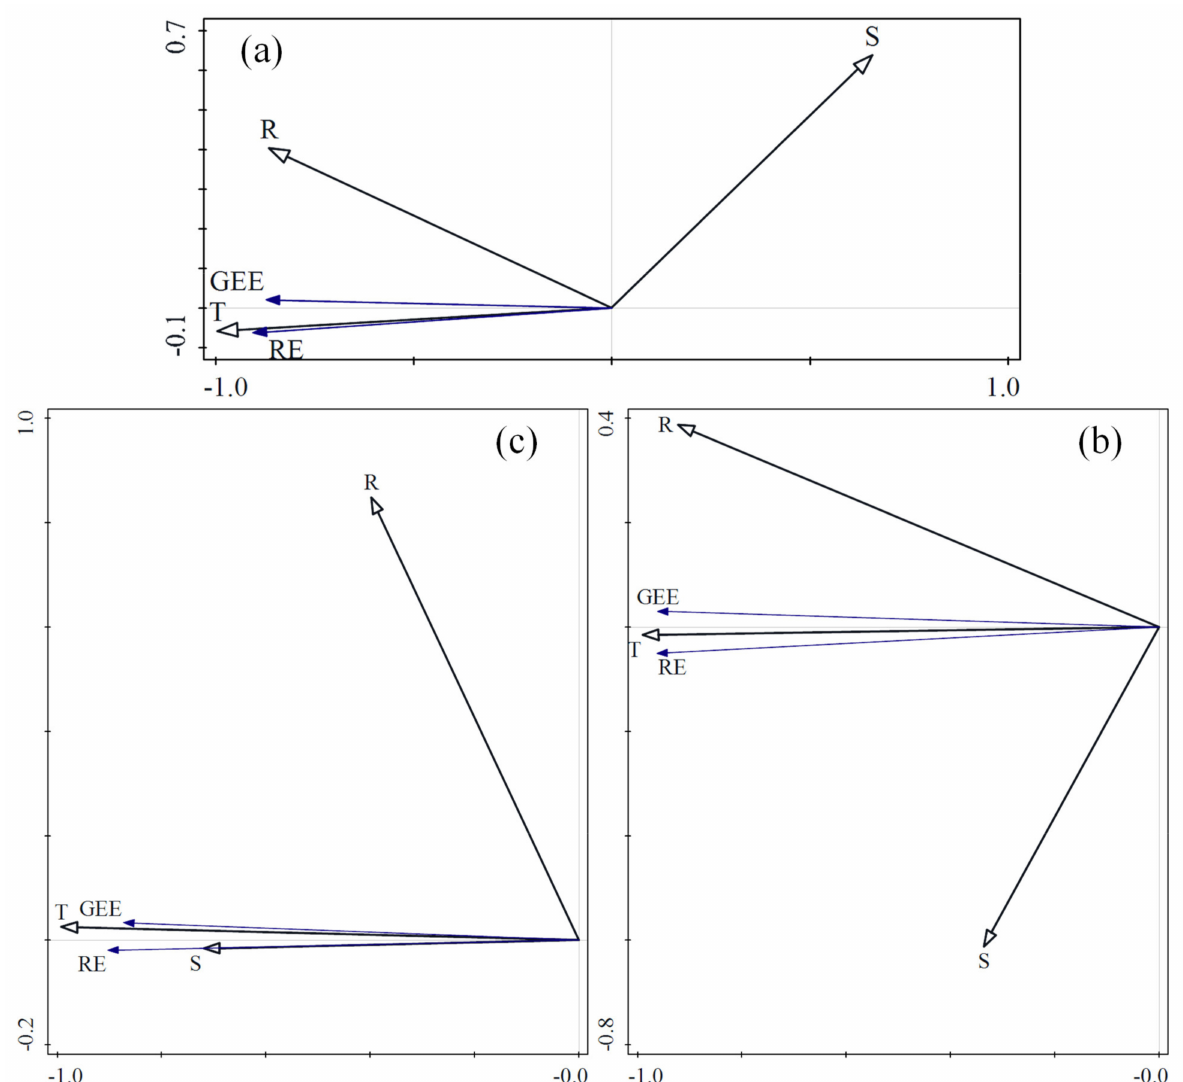
Figure 5. Redundancy analysis of temperature, moisture, photosynthetically active radiation, ecosystem respiration, and gross ecosystem exchange in temperate grassland ( a ), subtropical artificial coniferous forest ( b ), and tropical rain forest ( c ). Note: RE is ecosystem respiration, GEE is gross ecosystem exchange, T is temperature, S is moisture, R is photosynthetically active